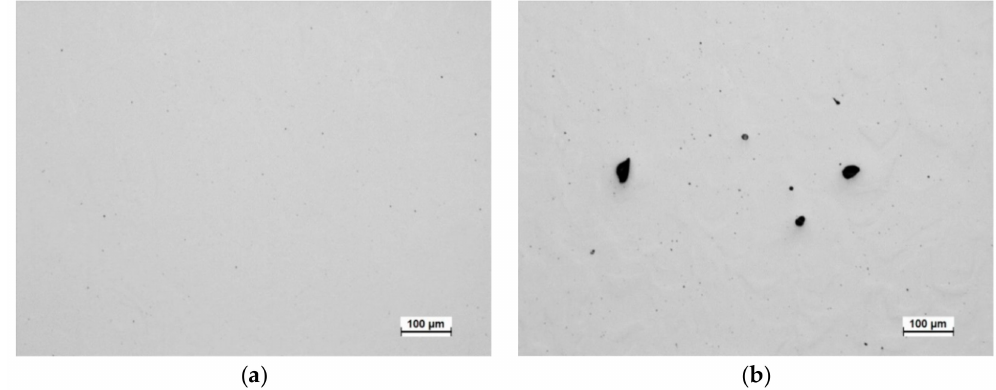
Figure 3. Optical micrographs of ( a ) the as-built sample processed with 66 ◦ rotation in scanning direction and ( b ) the as-built sample processed without rotation in scanning direction between the